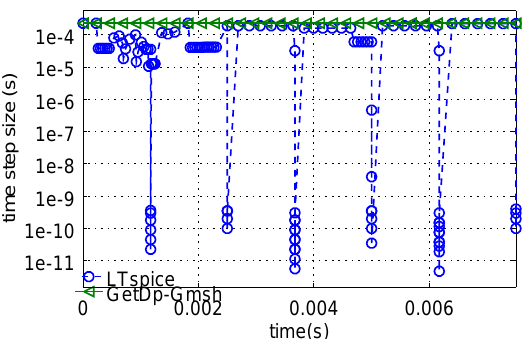
Figure 6: The time steps considered by the circuit